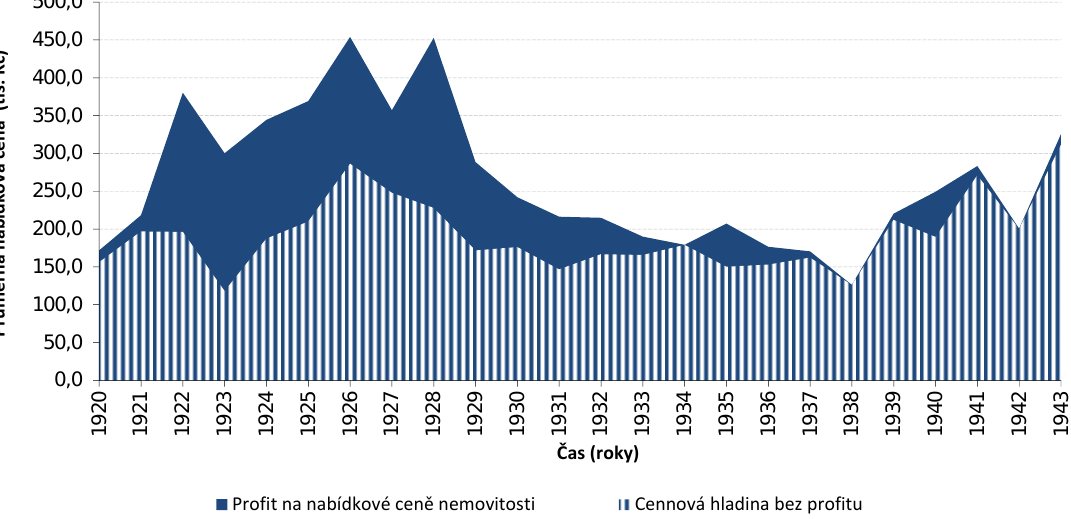
Obrázek 8: Zobrazení průměrného profitu při prodeji rodinného domu v Praze. Dále bude pozornost soustředěna na jednotlivé části Prahy dle aktuálního rozčlenění. Inzeráty byly rozděleny na segmenty Prahy 1 až Prahy 22. U některých inzerátů nebylo možné zjistit, do jaké části Prahy patří a tak jsou zařazeny do speciální kategorie: Praha – nezařazeno. Obrázek 9 nastiňuje situaci průměrné ceny rodinného domu dle lokality v Praze.